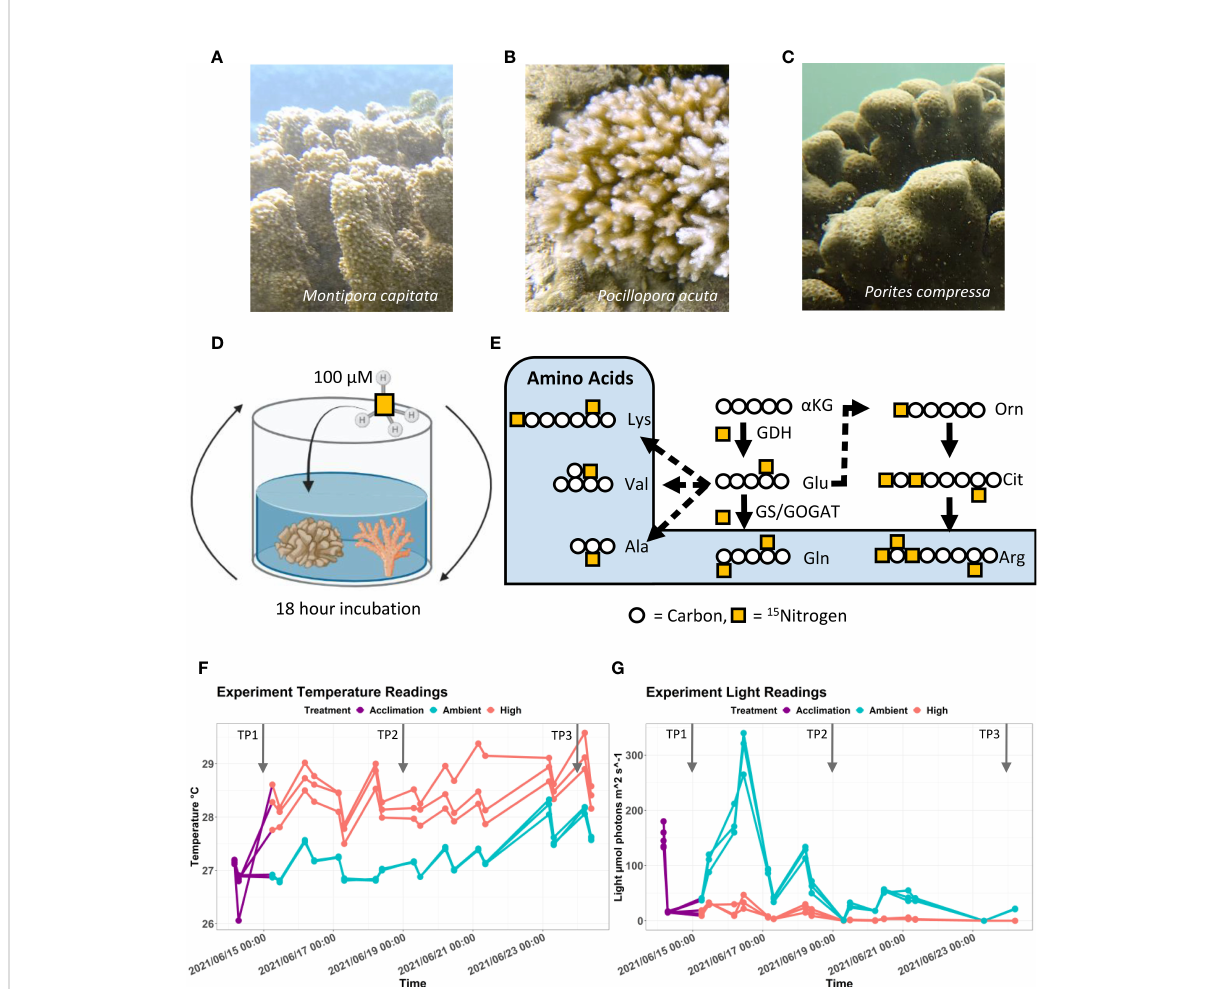
FIGURE 1 Culture and 15 N labeling of Hawaiian stony corals. (A – C) Images of Montipora capitata , Pocillopora acuta , and Porites compressa from Ka ̄ ne ’ ohe Bay, O ’ ahu. Photo credit: D. Bhattacharya. (D) Schematic of the experimental design depicting an isotopic incubation of stony corals in fi ltered seawater supplemented with 100 µM 15 N-NH 4 Cl. (E) Pathway showing the incorporation of ammonia as a nitrogen source into corals. Nitrogen is assimilated from ammonia to a -ketoglutarate to produce glutamate by the enzyme glutamate dehydrogenase (GDH). A further nitrogen atom is incorporated through amination onto glutamate to produce glutamine with the enzymes glutamine synthetase (GS) and/or